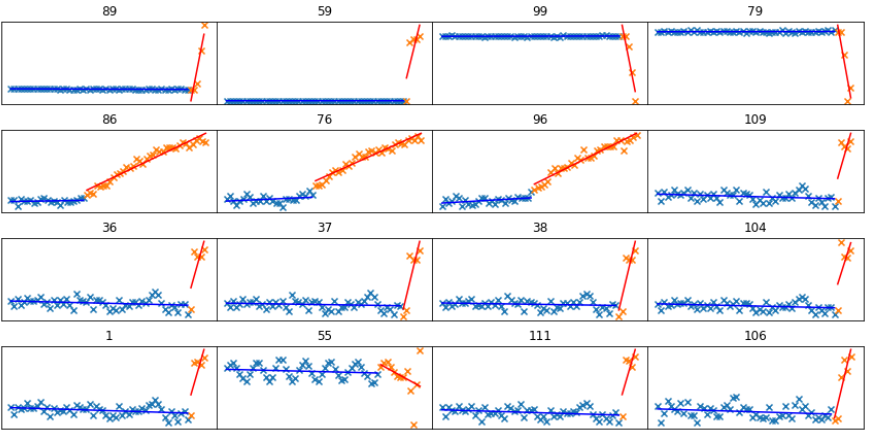
Figure 22. The linear fitting of 16 abnormal variables when t = 1236 min in Mode 3.